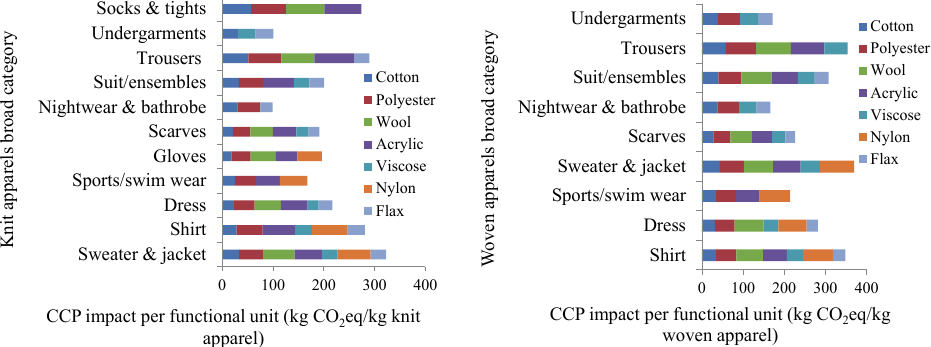
Fig. 5. CCP impact (per kilogram apparel) of knit and woven apparel broad